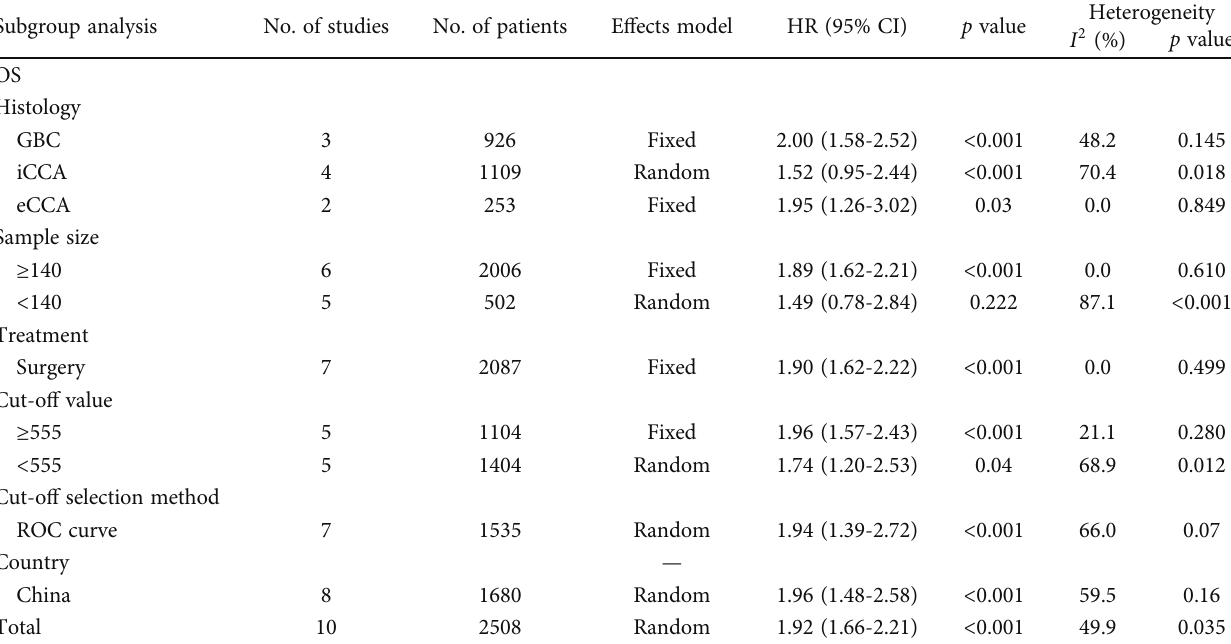
Figure 2: Forest plots of the association between the systemic immune-in fl ammation index and OS in patients with biliary tract cancer. CI: con fi dence interval; HR: hazard ratio. Table 2: Subgroup analyses for OS and RFS based on di ff erent